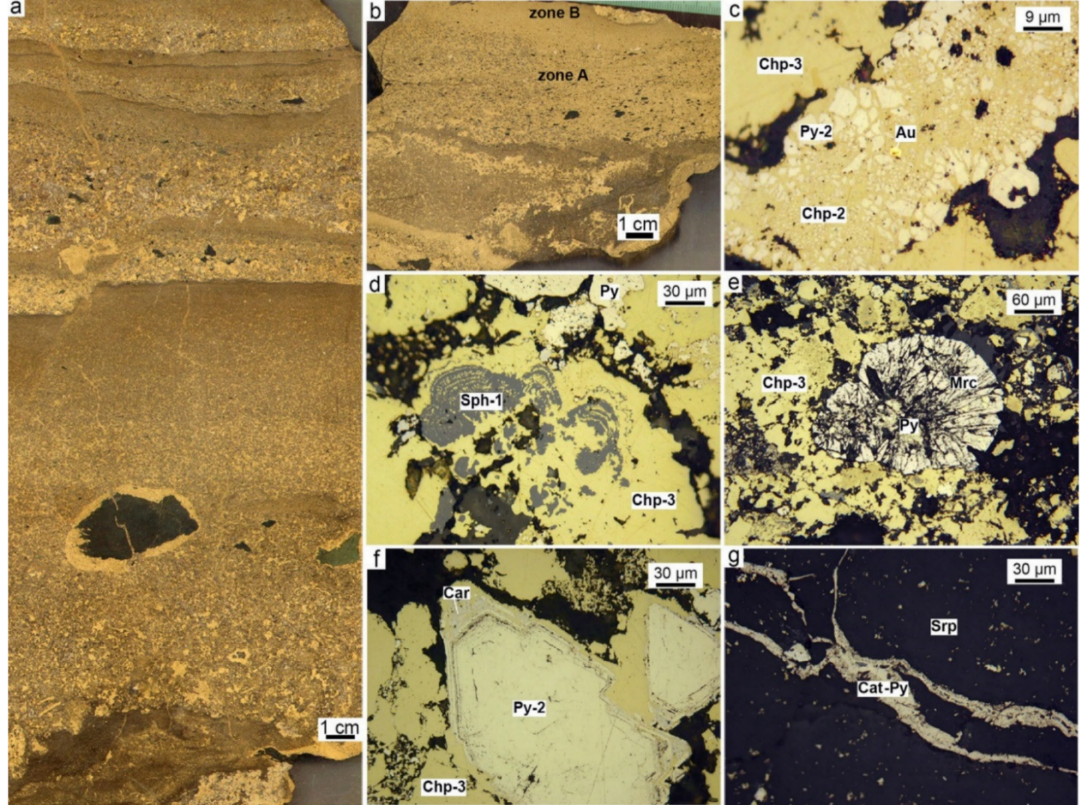
Figure 6. Mineralogical features of chalcopyrite-rich diagenites of the Dergamysh deposit: ( a ) Chalcopyrite nodules with serpentinite cores in sulfide turbidite; ( b ) chalcopyrite-rich diagenites enriched in fine-grained chalcopyrite in the upper part of the rhythms (zone B) and relict pyrite and serpentinite (black) clasts in the lower part (zone A); ( c ) authigenic native gold in chalcopyrite-2 replacing pyrite fragments; ( d ) replacement of sphalerite clasts by chalcopyrite-2; ( e ) radial columnar marcasite nodule in chalcopyrite-2; ( f ) replacement of euhedral zonal pyrite crystal by chalcopyrite-2 and carrollite ( g ) veinlets of a phase of intermediate composition between cattierite and pyrite (Cat-Py) with inclusions of cobaltite in the serpentine core of the chalcopyrite nodule; ( a , b ) Polished sample, ( c – g ) reflected